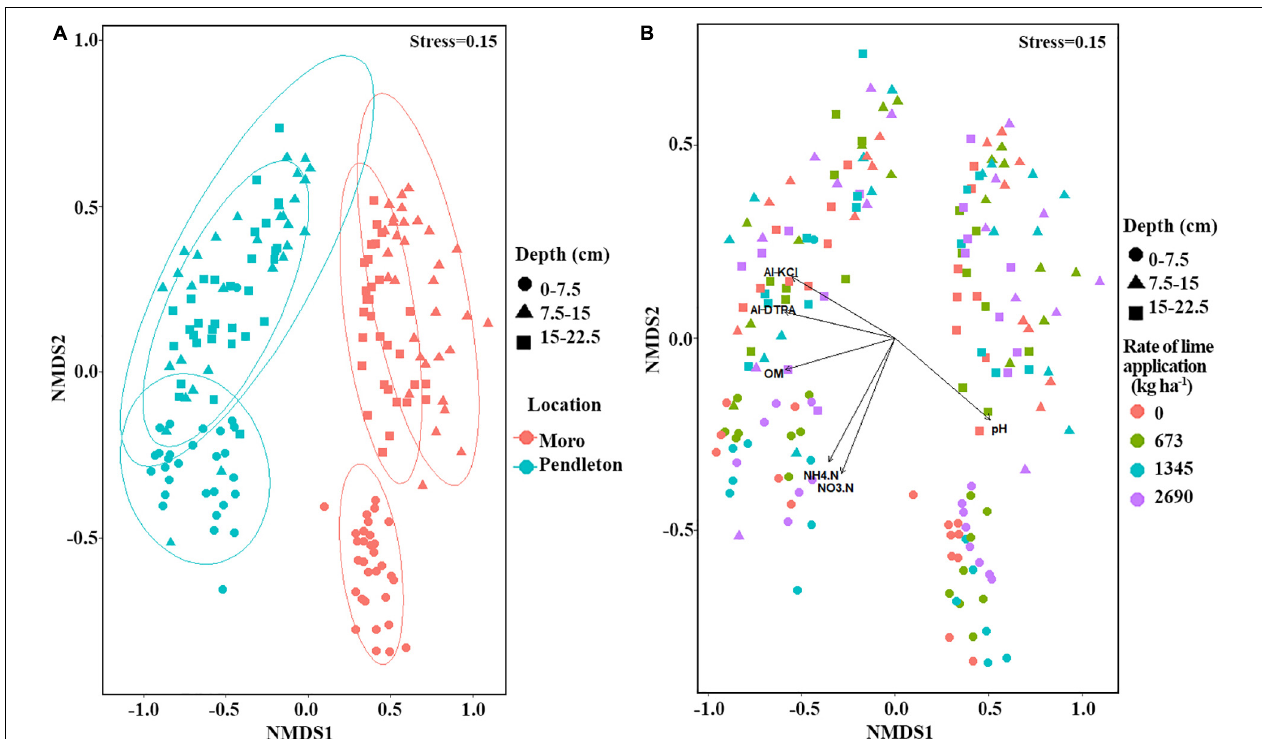
FIGURE 3 | Non-metric multidimensional scaling (NMDS) of fungal community from all samples (Bray-Curtis distances). (A) NMDS of fungal community within location and soil depth. (B) NMDS of fungal community within soil depth and lime application. Symbols represent soil depth and colors represent location or rate of lime application. Vectors represent significant associations of soil chemical factors along with axes (vegan, p ≤ 0.05). Al-DTPA, DTPA extractable aluminum; Al-KCl, KCl extractable